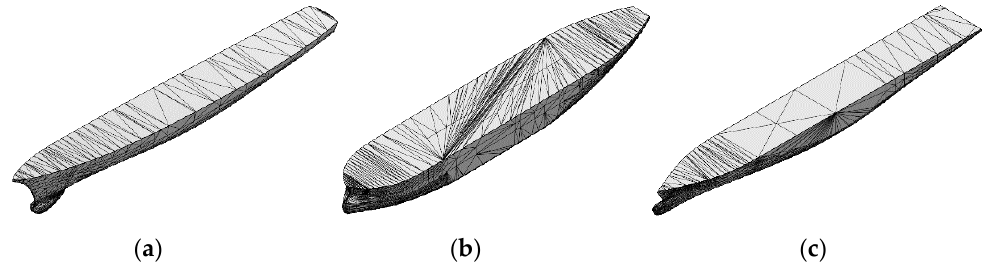
Figure 3. STL model of hulls ( a ): DTMB 5415, 5088 facets, ( b ): KVLCC2, 24,586 facets, ( c ): KCS, 8340 facets).